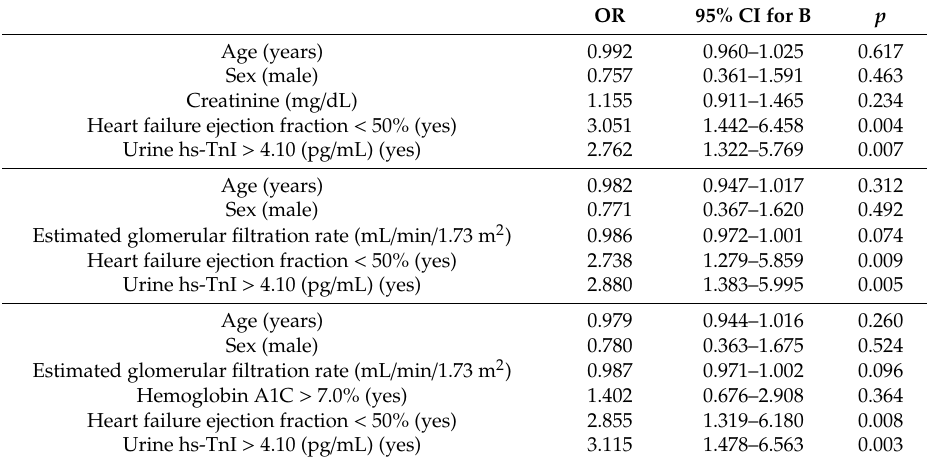
Table 2. Multivariate logistic regression analysis of independent predictors for subsequent incident CV events in patients with